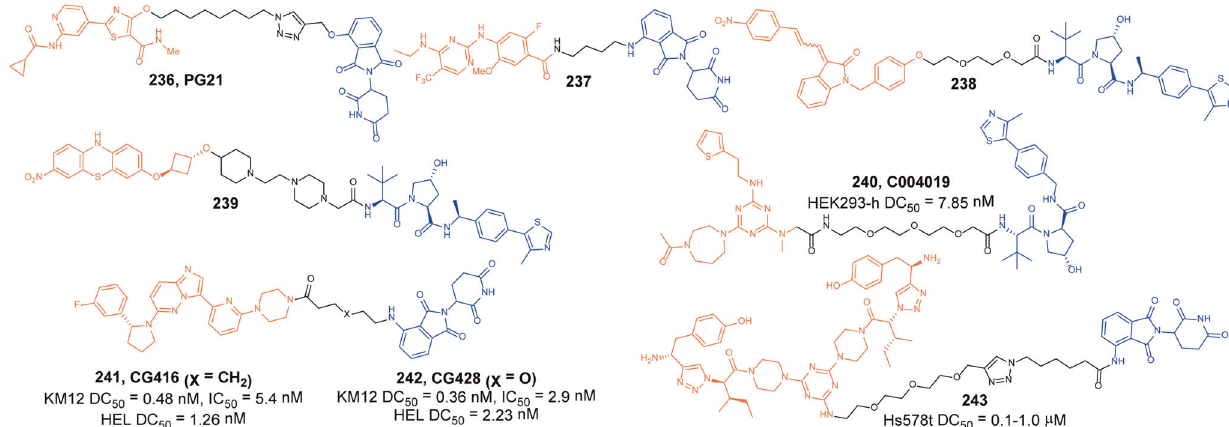
Fig. 80 The representative PROTACs targeting neurodegenerative